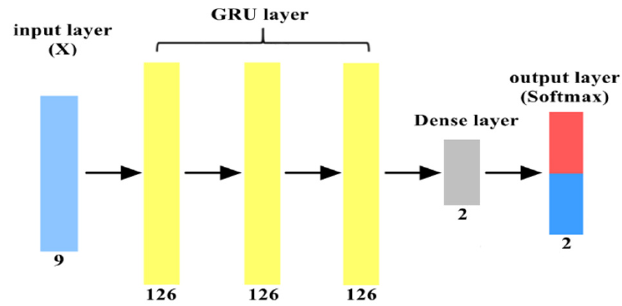
Figure 7. The DAE model of our approach.